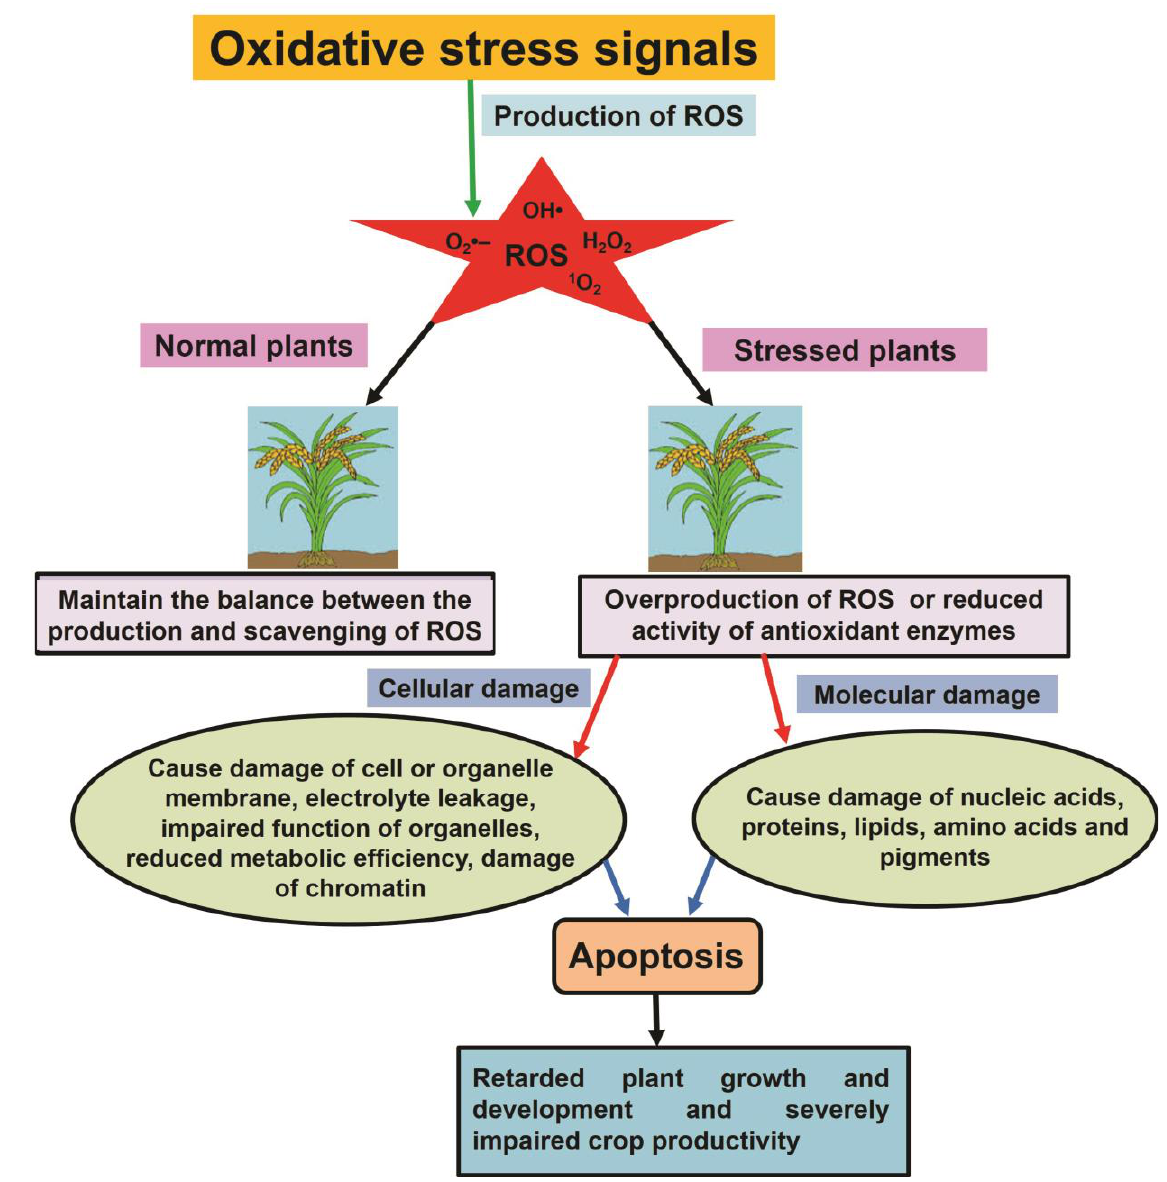
Figure 1. Excessive production of reactive oxygen species (ROS) in plants causes oxidative stress, leading to apoptosis, which severely affects plant growth and productivity. HO•, hydroxyl radical; leading to apoptosis, which severely affects plant growth and productivity. HO • , hydroxyl radical; H 2 O 2 , hydrogen peroxide; O 2 •−, superoxide radical; and 1 O 2 , singlet oxygen. H 2 O 2 , hydrogen peroxide; O 2 •− , superoxide radical; and 1 O 2 , singlet